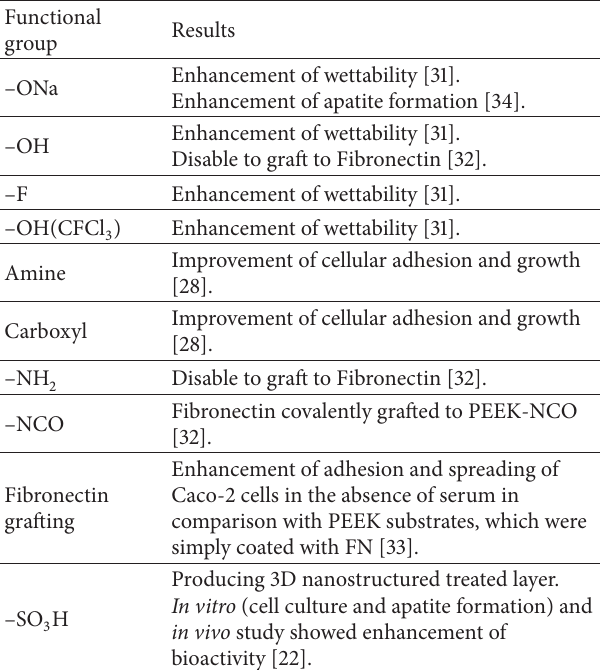
Table 1: Deposited functional groups on PEEK via wet chemical